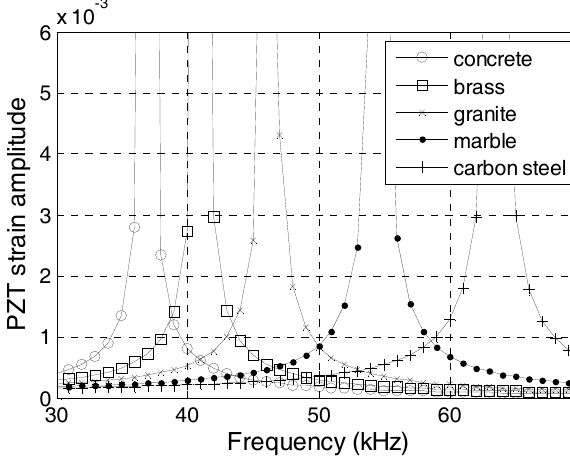
Figure 8. Frequency-strain curve with different protecting layer materials.